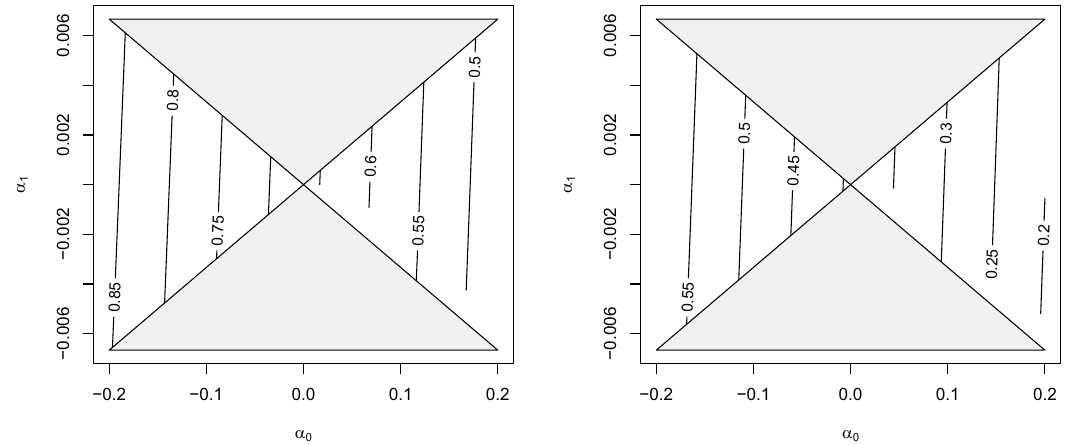
Figure 2: The estimated marginal causal log odds ratio for behavior pattern and CHD ( left panel ) and its lower pointwise 95% con fi dence limit ( right panel ) , as functions of the sensitivity parameters α 0 and α 1 . The gray areas correspond to values of α 1 outside the